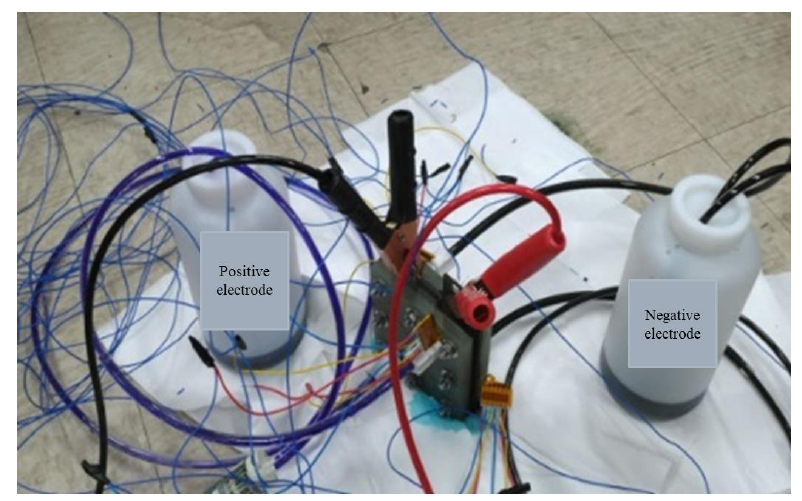
Figure 13. Charging diagram of micro-sensor embedded in